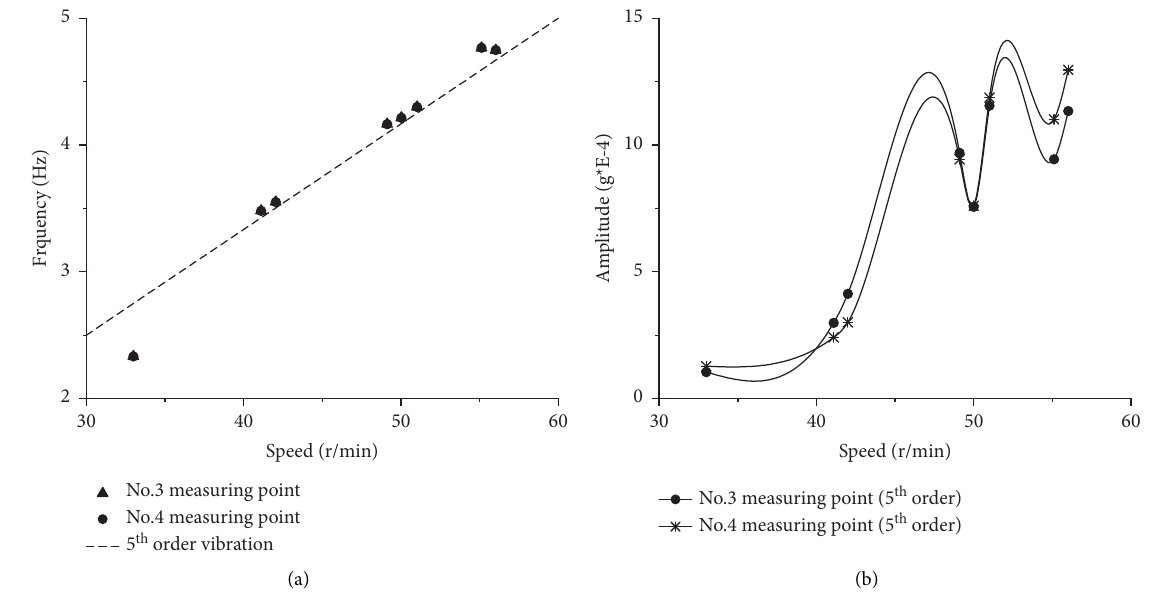
Figure 10: Main parameters of hull longitudinal vibrations. (a) Frequency (b) Amplitude. Table 4: Main data of Hull Transverse Vibrations.